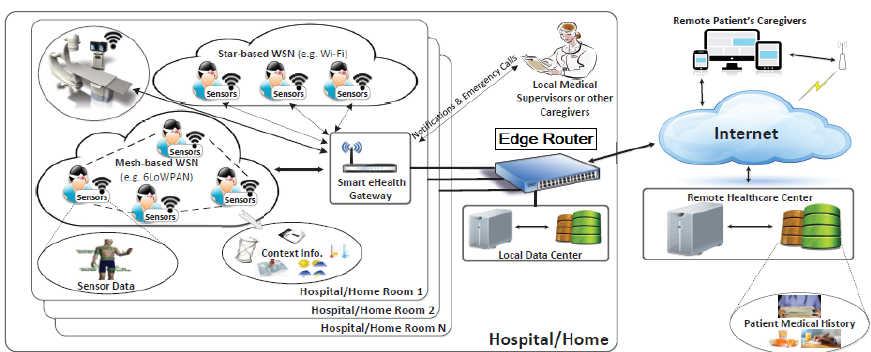
Figure 1. Smart Hospital